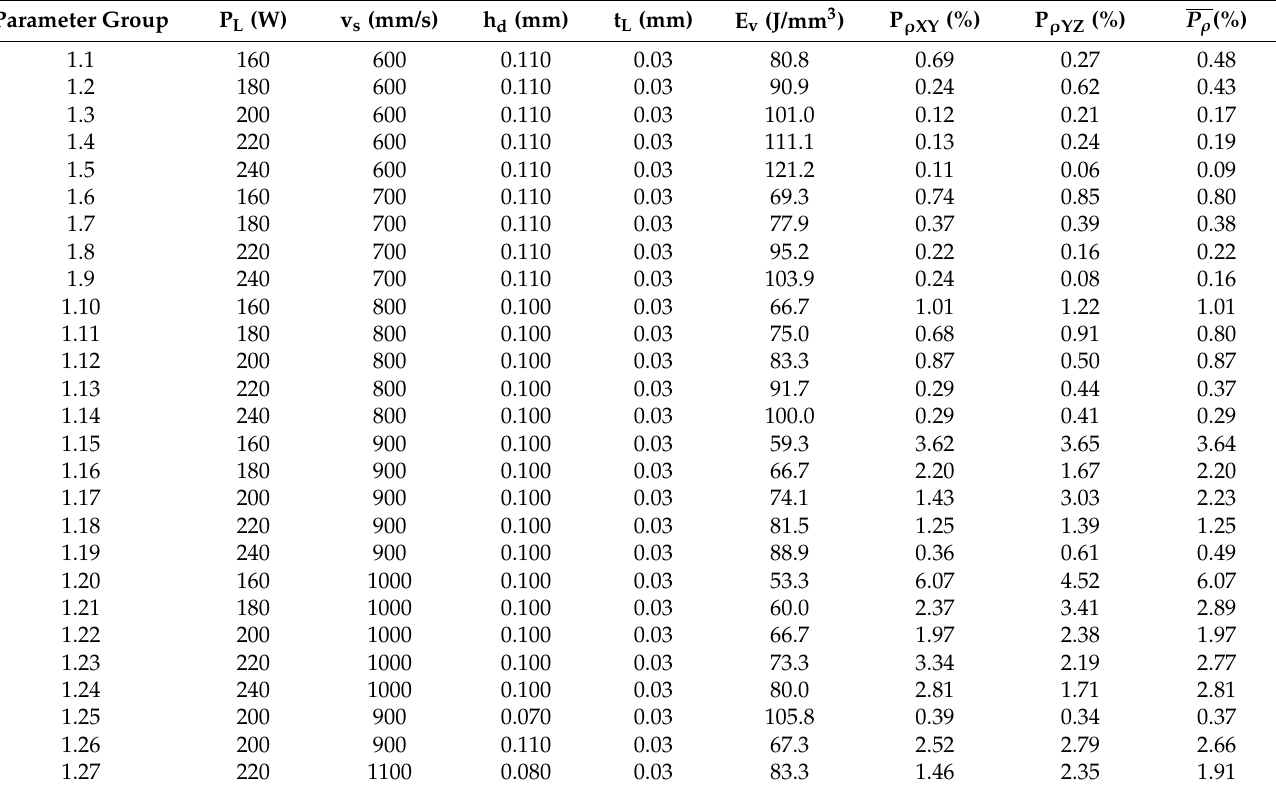
Table A1. Values of process parameters for individual groups and results of measurements of the porosity of samples produced using these